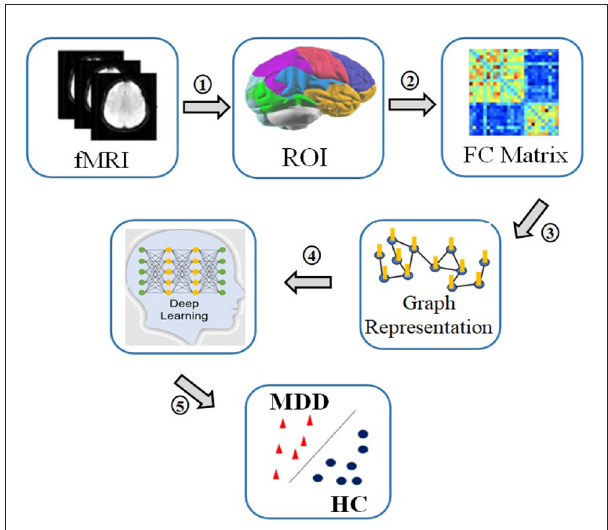
FIGURE1 The process of MDD and HC classif ication: 1. Recording R-fMRI signal, 2. Extracting time series of regions of interest, 3. Calculating correlation matrices of the time series, 4. Converting correlations in graph representations, 5. Applying deep learning to classify between patients and